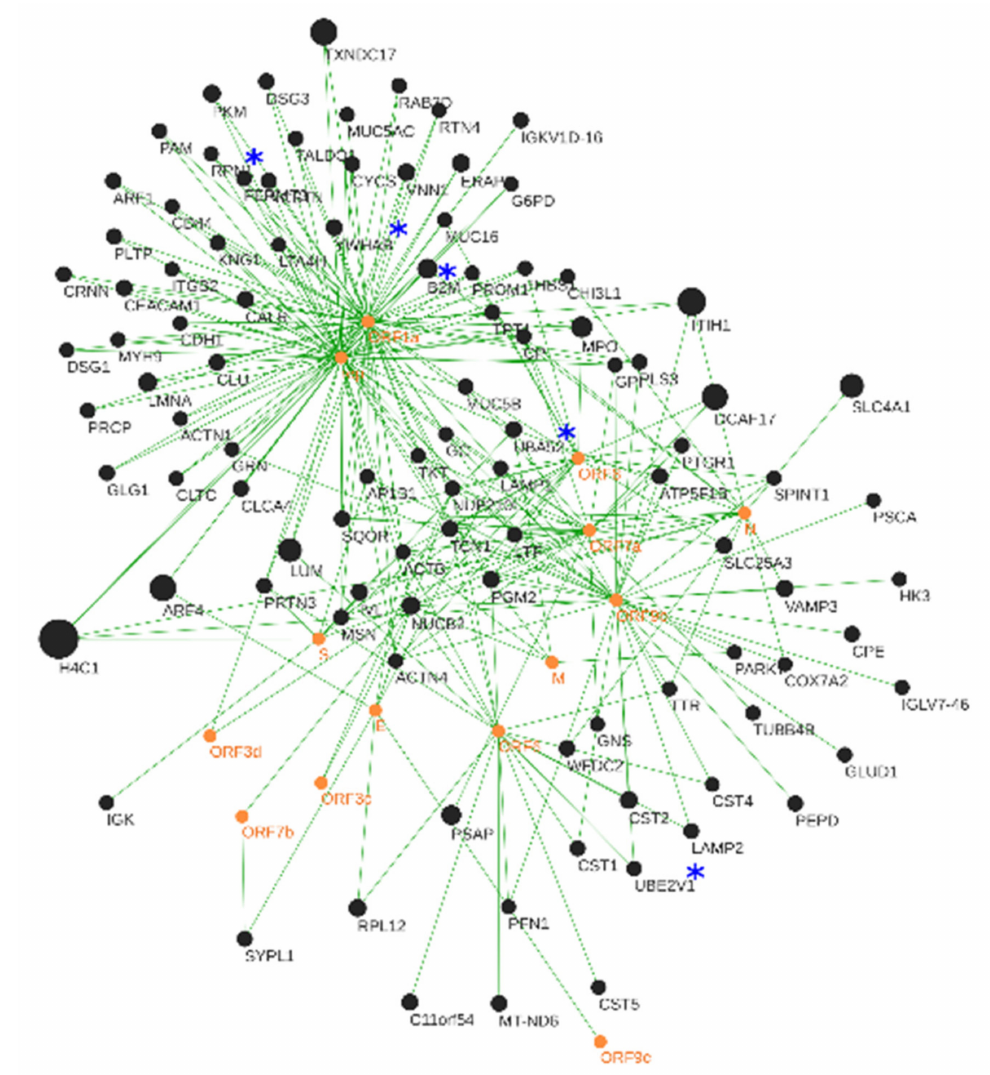
Figure 4. High-confidence network of interactions (263 interactions) resulted from the input of 642 human proteins and the SARS-CoV-2 reference proteome (14 proteins) predicted by OralInt. Network visualization was done using Cytoscape. SARS-CoV-2 proteins in orange, human proteins in black. Hub proteins in bold. Node size is proportional to the absolute value of the fold change. * Represent the five proteins already identified in the SARS-CoV-2 pathway by